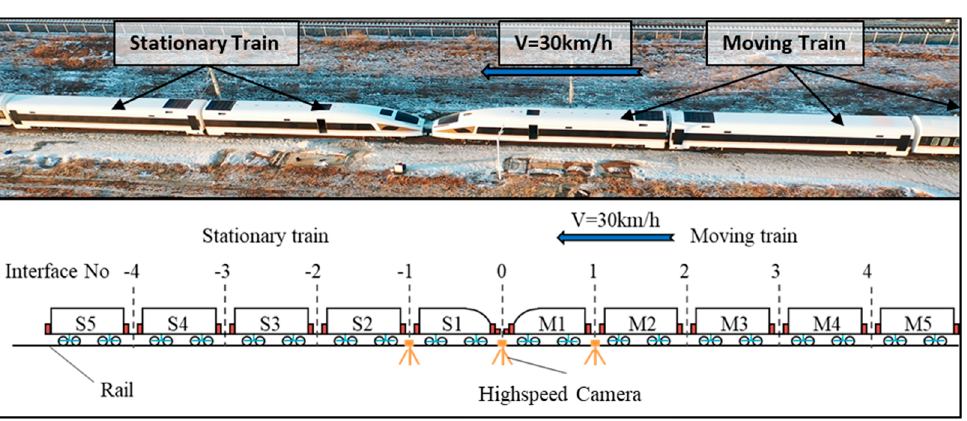
Figure 7. Dynamic response of each vehicle during the whole process of vehicle collision based on dynamic simulation result.